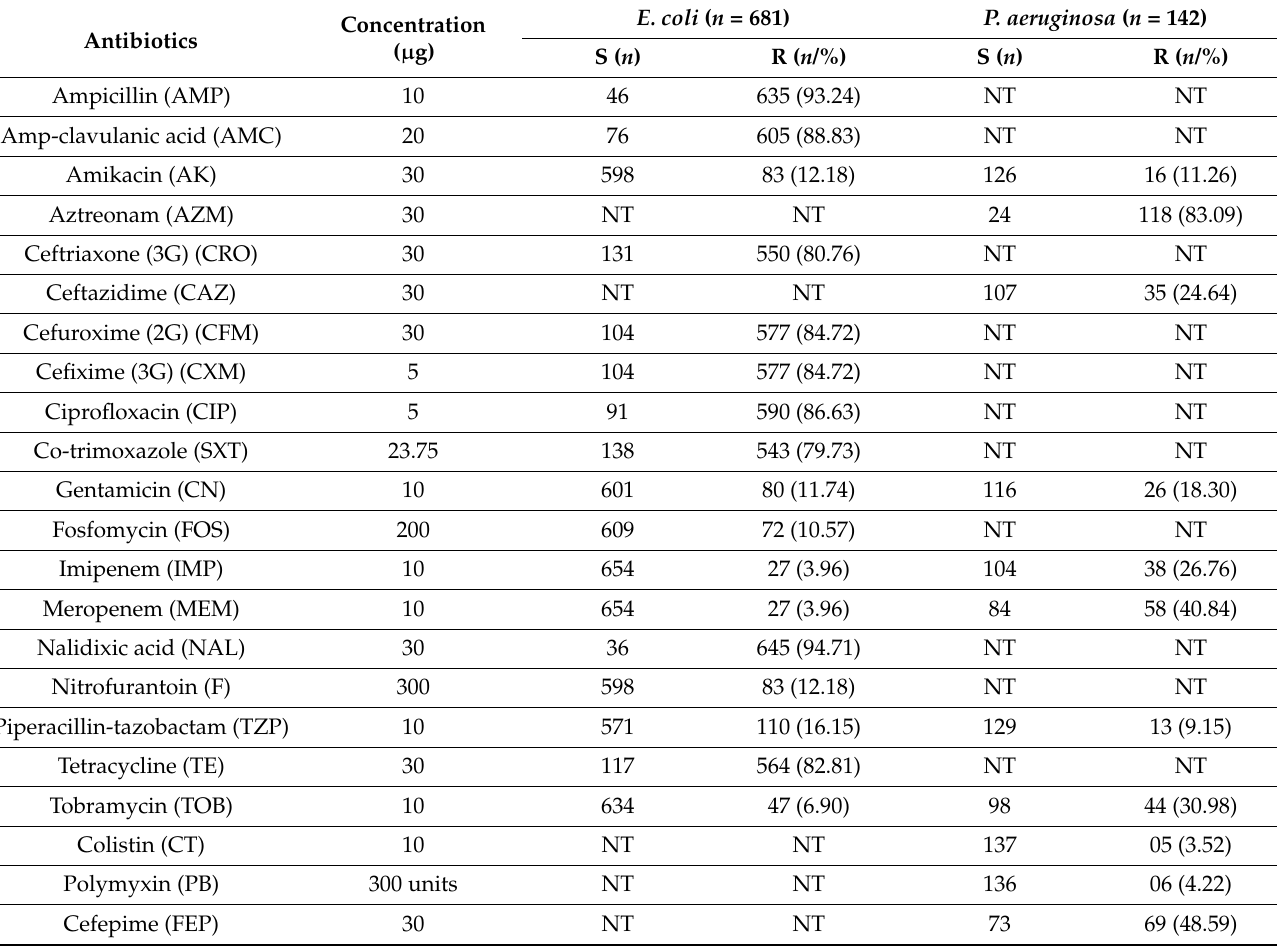
Table 2. Antibiotic resistance pattern of E. coli and P. aeruginosa